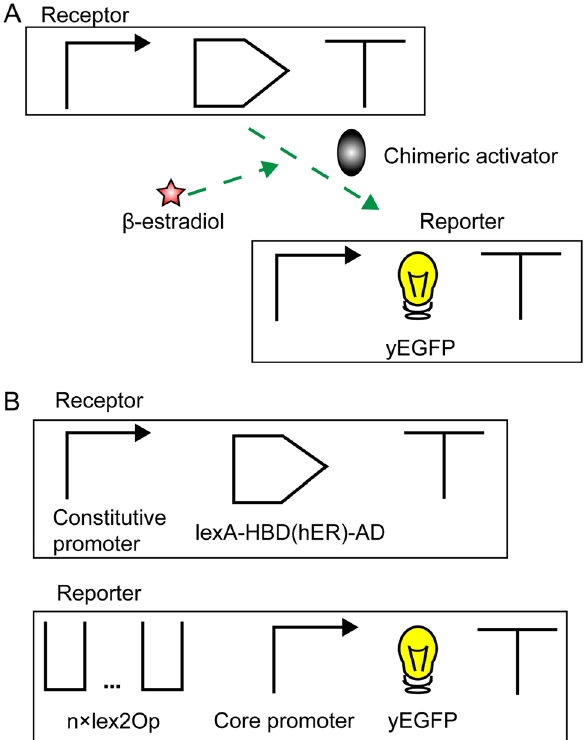
Figure 1. The β-estradiol biosensor. ( A ) Biosensor scheme. The dashed arrow means that the activator protein cannot bind and activate the target promoter in the absence of its inducer. ( B ) Structure of the two TUs in our β-estradiol biosensors. The number (n) of lex2Op used in this work goes from 1 to